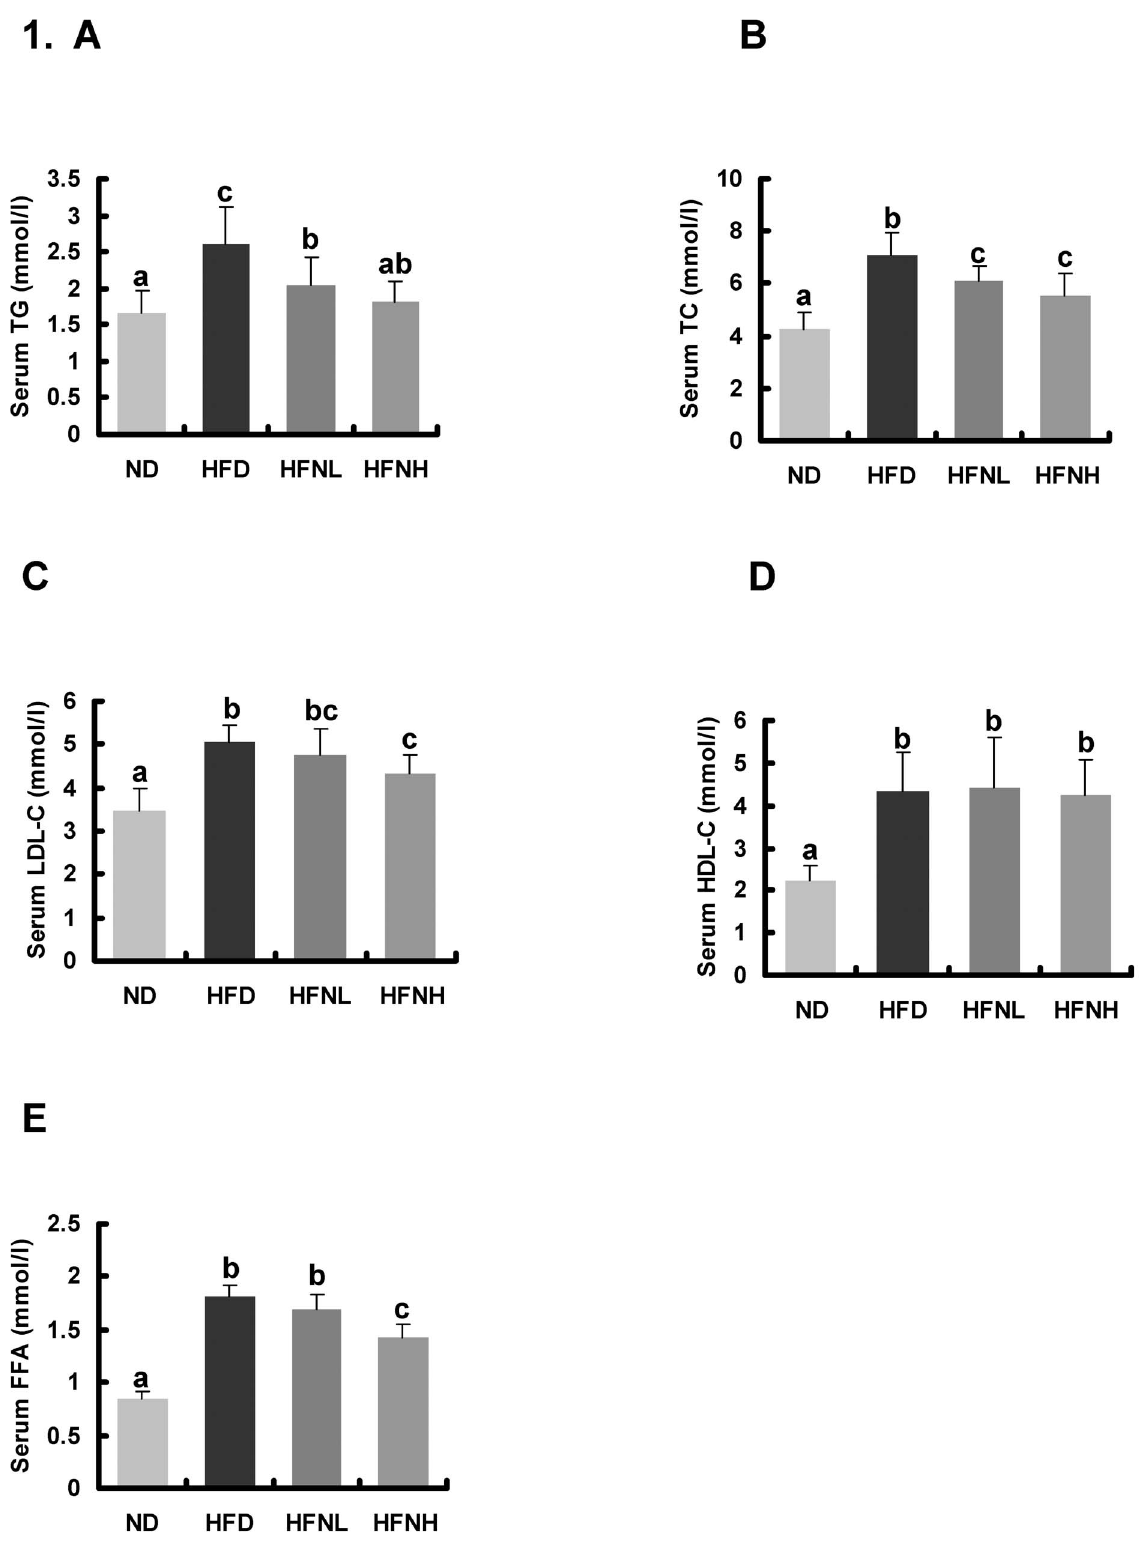
Figure 1. Effects of nuciferine on serum lipid profile and free fatty acid. (A) Serum triglyceride, (B) serum total cholesterol, (C) serum low- density lipoprotein cholesterol, (D) serum high-density lipoprotein cholesterol, and (E) serum free fatty acid. Values are means 6 SD, n=10 hamsters in each group. ND: normal diet group, HFD: high-fat diet group, HFNL: low dosage nuciferine group (HFD + 10 mg/kg ? BW/day), HFNH: high dosage nuciferine group (HFD + 15 mg/kg ? BW/day). a, b, c: Means in the same row with different online letters differ significantly, p , 0.05.